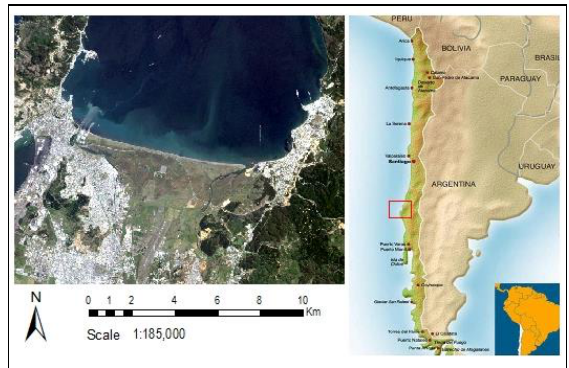
Figure 2. The research area